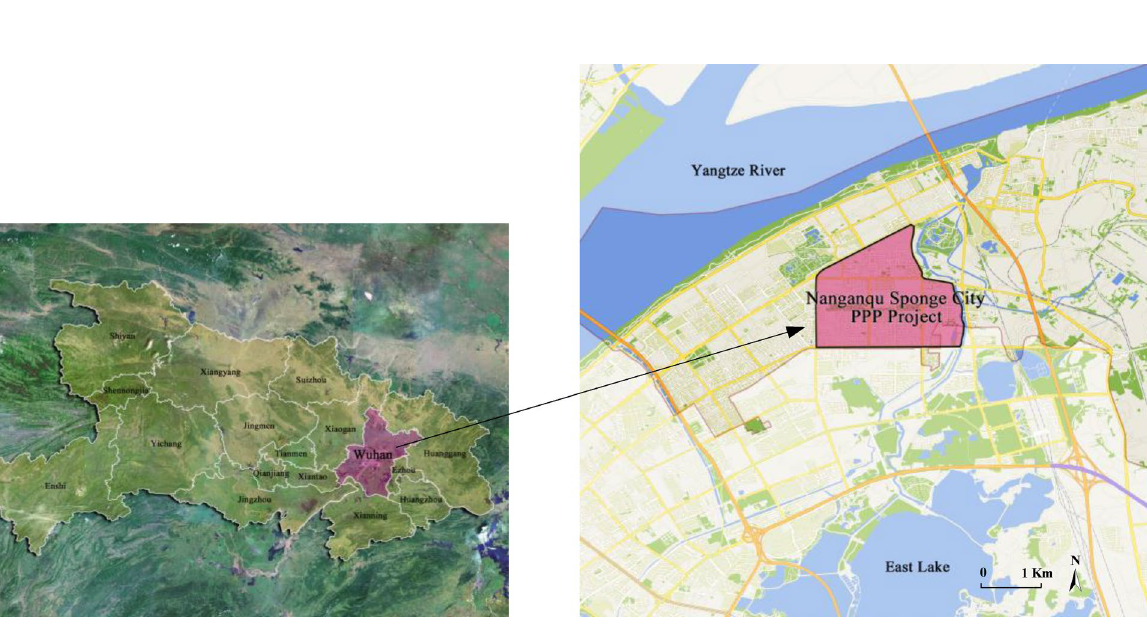
Figure 12. Location of the study